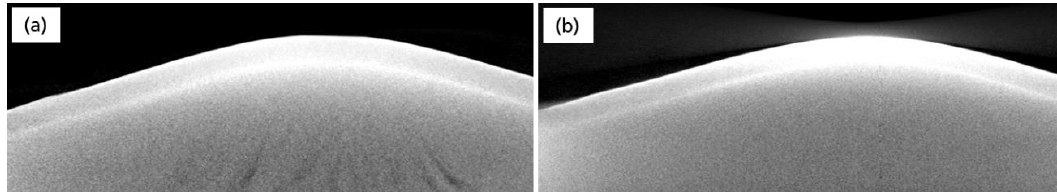
Figure 10. Comparison of the Bragg influence on different CT modalities in the ex situ case. Image ( a ) shows a helical-CT scan with additional contrast appearing inside the bulk crystal. Image ( b ) shows a standard 3D-CT scan without the effects. Both scans were acquired at identical X-ray energy settings at 125 kV and no additional pre-filtration.